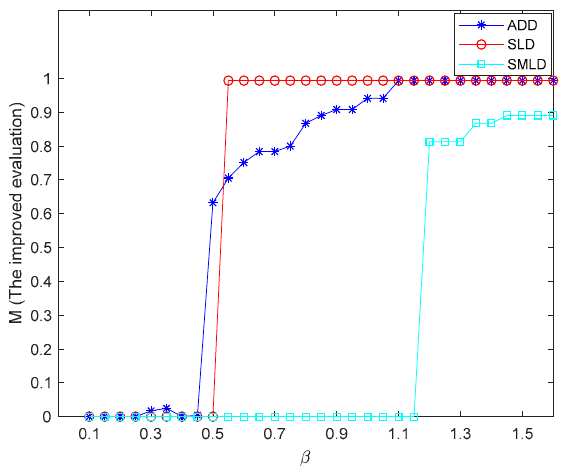
Figure 7. The influence of different distributions working on M.